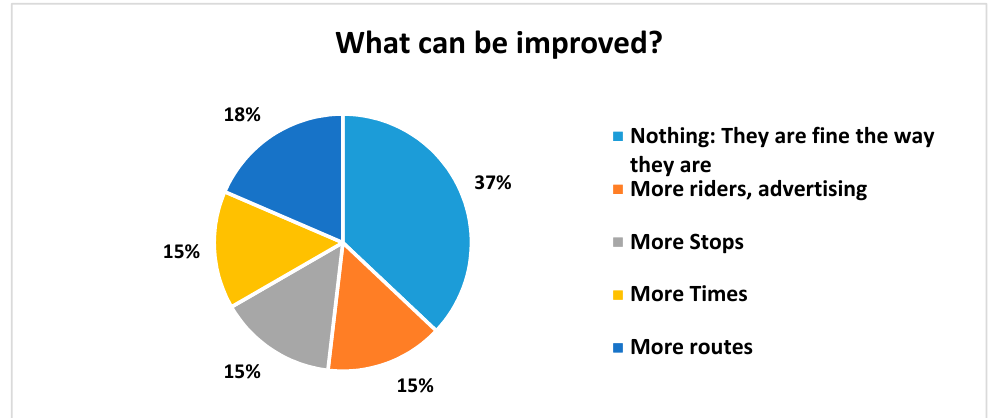
Figure 8. What do you like about the bus service?